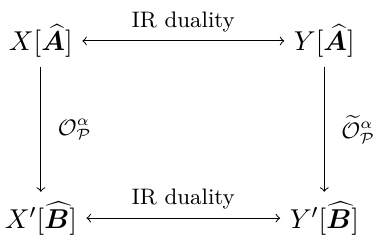
Figure 1 . Generating new dual pairs using an elementary S -type